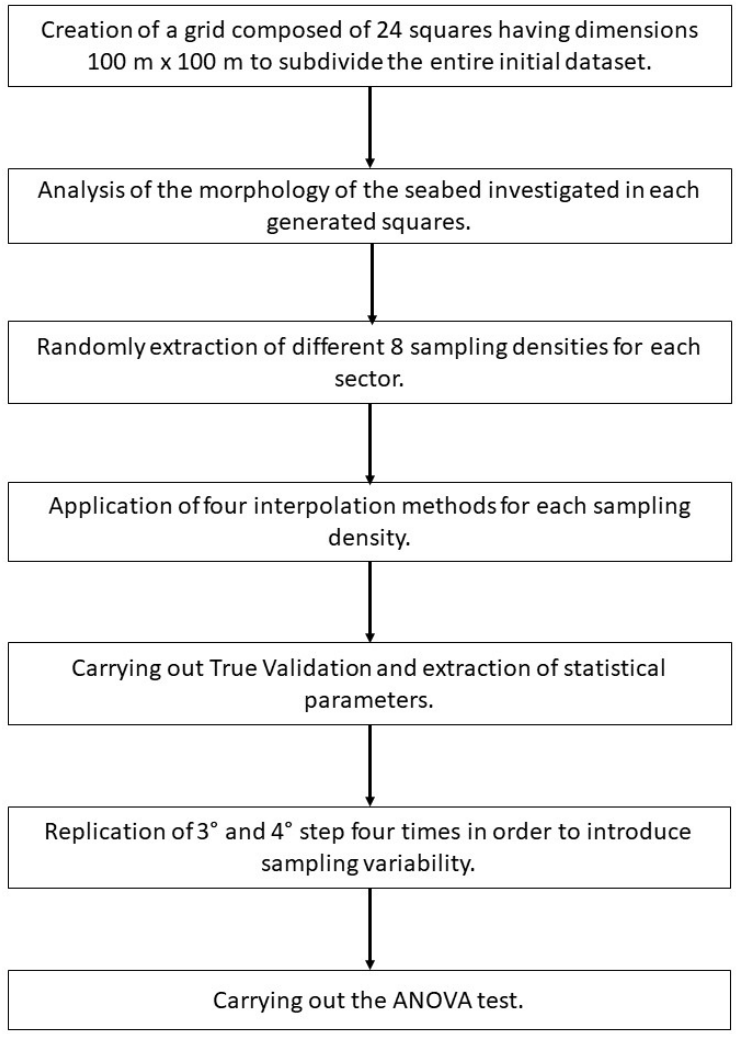
Figure 1. Flowchart of the methodological phases carried out in this study.